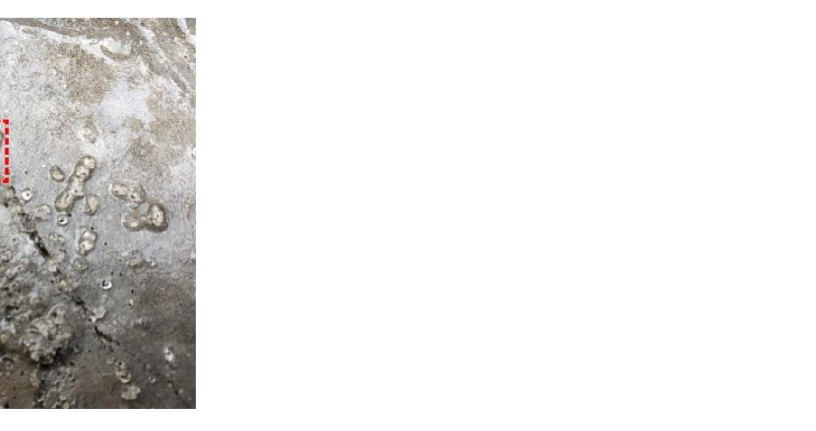
Figure 13. Surface of specimen mixed with citric acid and SAP. Reprint with the permission from ref.[7]. Copyright 2022 Elsevier.